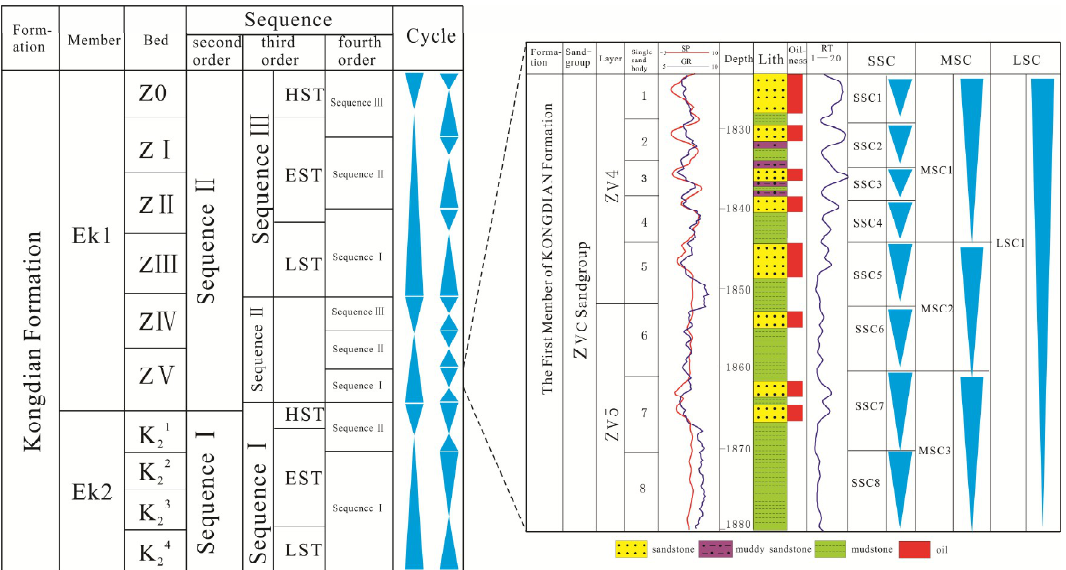
Figure 3. The synthetic pattern of the base-level cycle of the study area. SP, spontaneous potential curve; GR, gamma-ray curve; RT, resistivity curve.